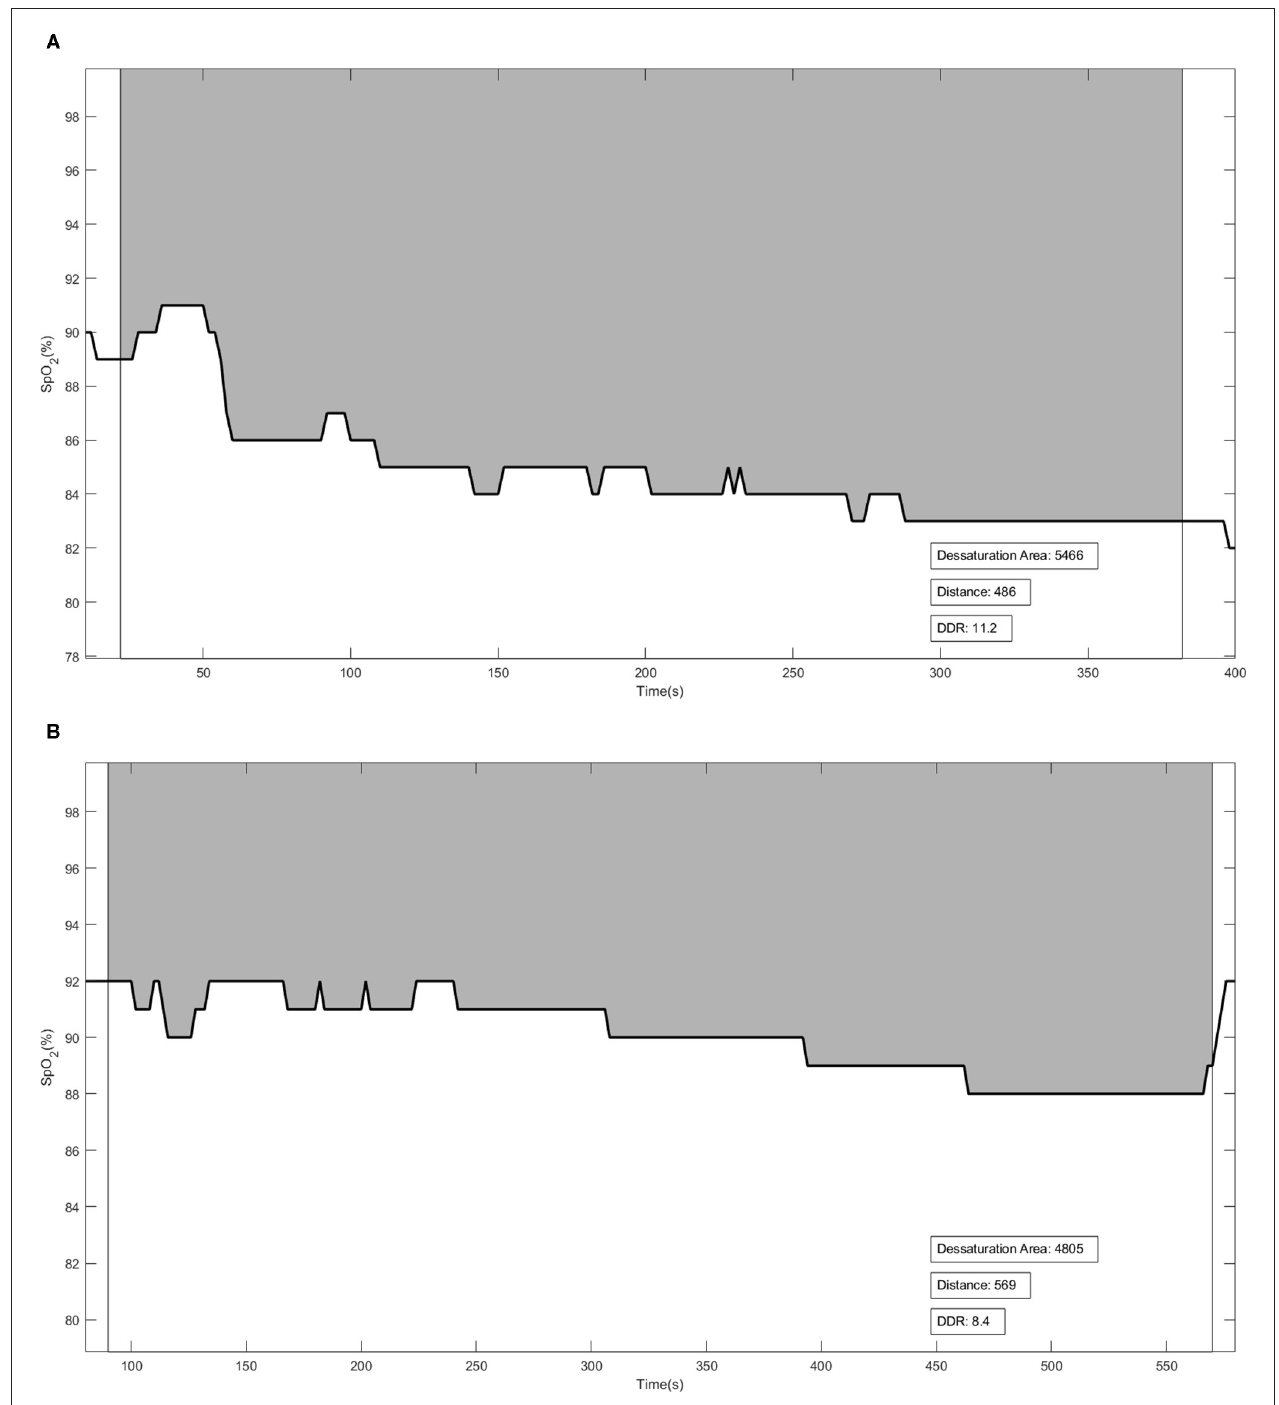
FIGURE 1 | Illustrative figures of the Desaturation-Distance Ratio (DDR) during the 6-min walking test (6MWT) (A) and incremental shuttle walking test (ISWT) (B) . The solid line represents the oxygen desaturation during the test. DDR was calculated using the ratio between DAO 2 [the gray area—obtained by subtraction between each recorded SpO 2 at every 2s from 100% (maximal SpO 2 )] and the distance walked. Distance in meters.